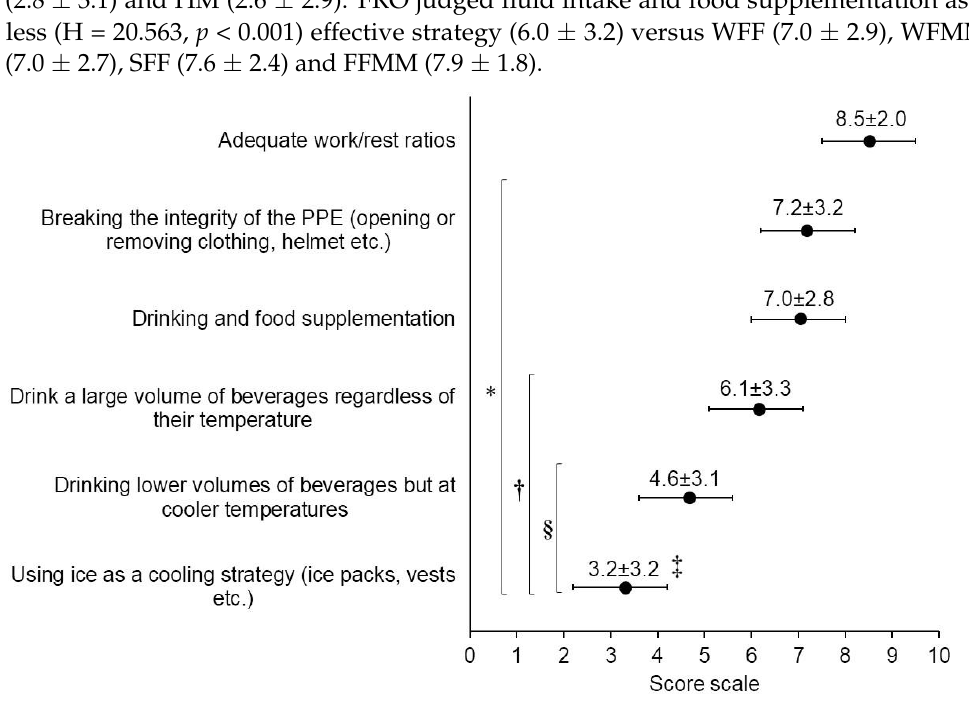
Figure 3. Perceived effectiveness of the heat strain mitigation strategies during wildland fire suppres- sion (mean ± SD). Score: 0 = not effective at all and 10 = totally effective . *: differences with adequate work/rest ratios; †: differences with breaking integrity of PPE and drinking and food supplemen- tation; §: differences with drinking a large volume of beverages regardless of their temperature; ‡: differences with drinking lower volumes of beverages but at cooler temperatures. All differences are significant at p < 0.001.